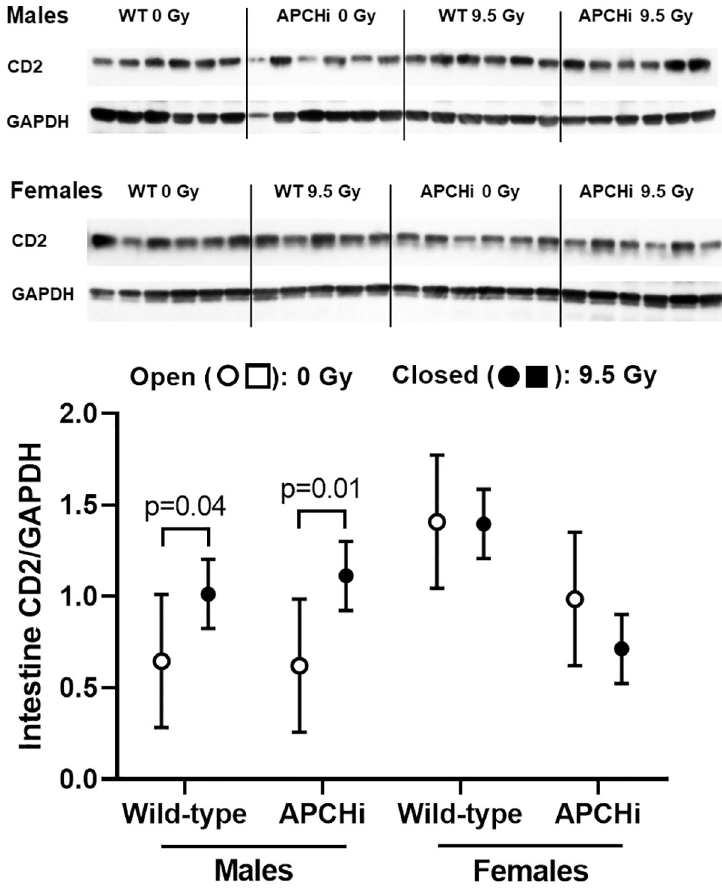
Fig 7. CD2 expression in the small intestinal wall at 6 months after irradiation. Immunoblotting was used to determine levels of CD2 corrected for loading control GAPDH. Graphs indicate means and SD of the statistical model; n = 5–6 mice per group. Brackets indicate significant differences between 0 Gy and 9.5